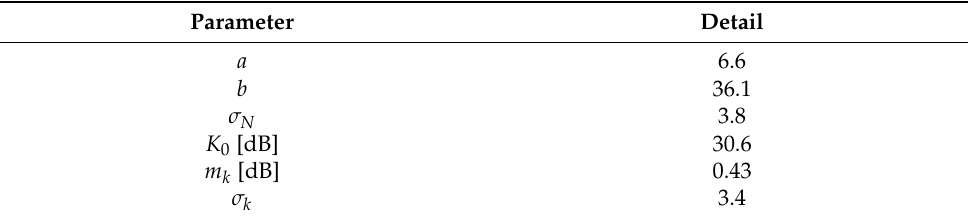
Table 7. Parameters of the IEEE model